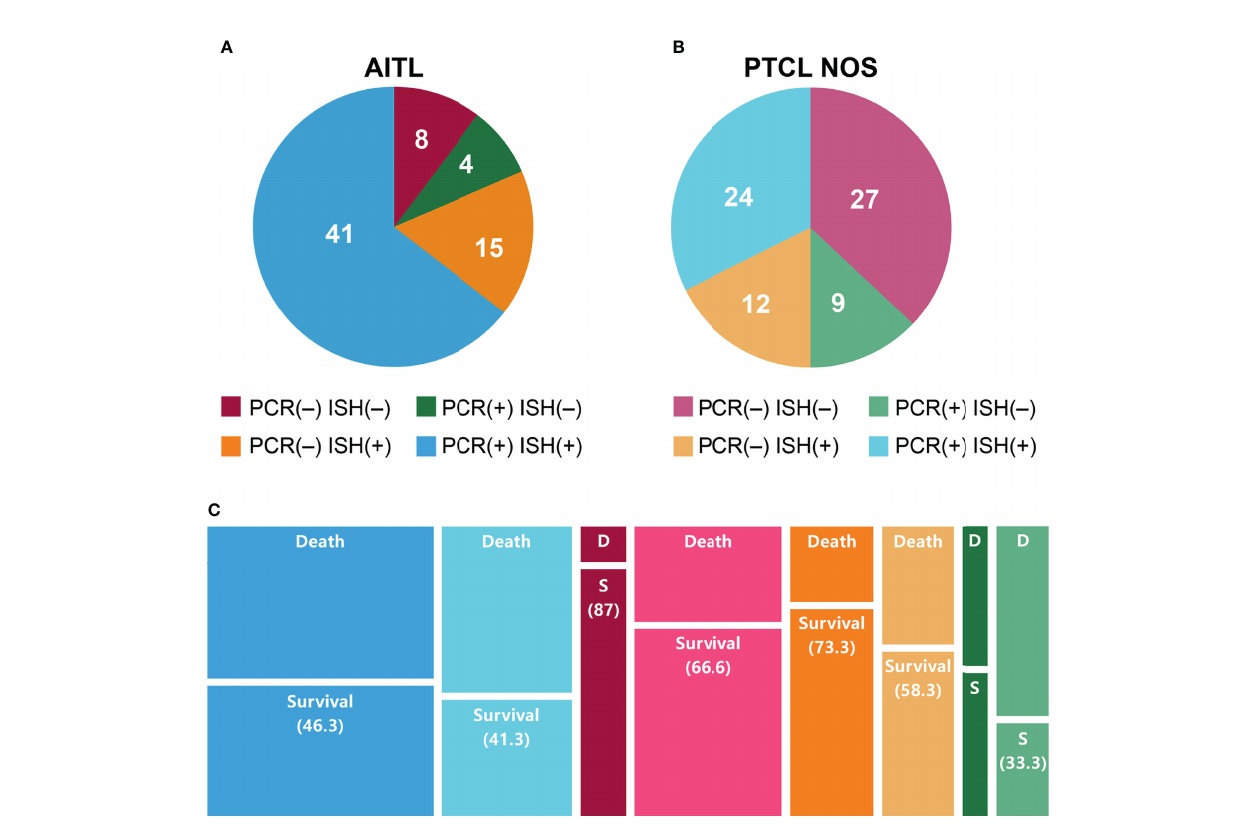
FIGURE 2 | EBV infection in patients with (A) AITL or (B) PTCL-NOS according to PCR and ISH. (C) Survival of patients with AITL or PTCL-NOS after 2 years based on EBV PCR and ISH